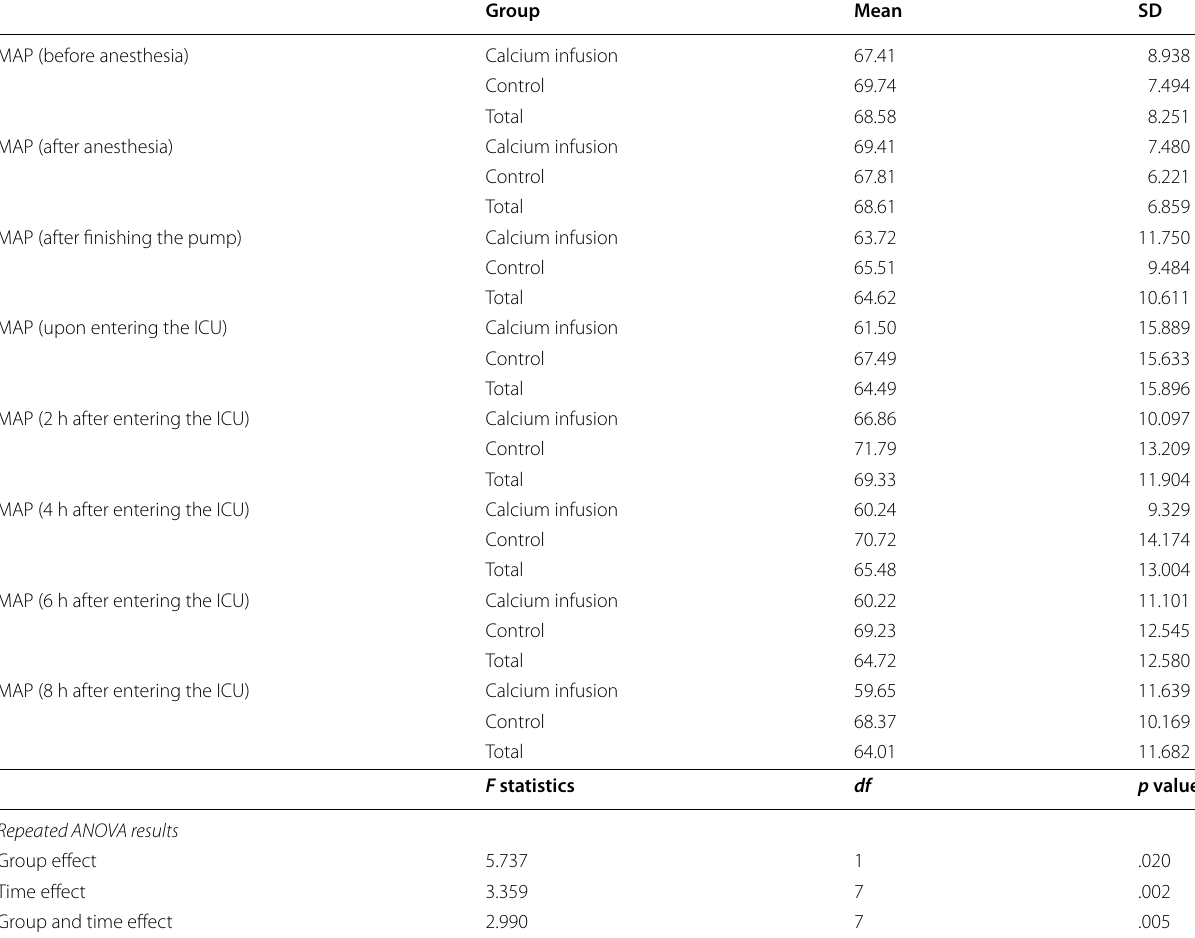
Table 6 Statistics of mean arterial pressure